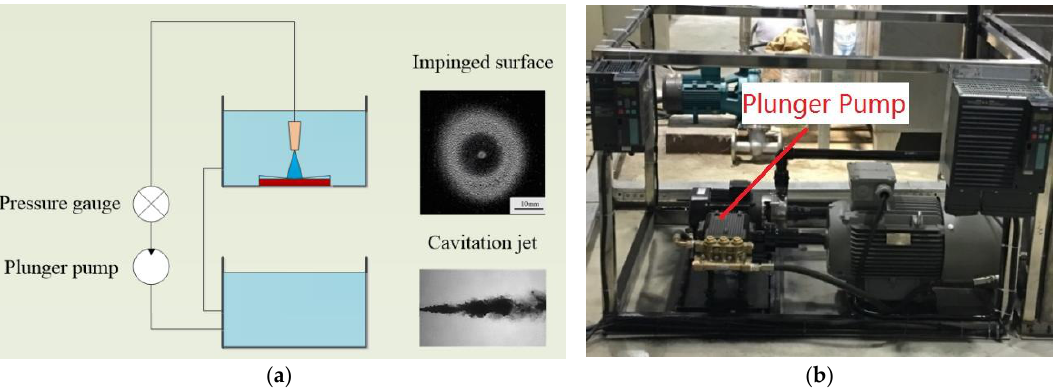
Figure 1. Test platform for high-pressure submerged jet. ( a ) Cavitation jet system. ( b ) Physical photographs of the test stand.